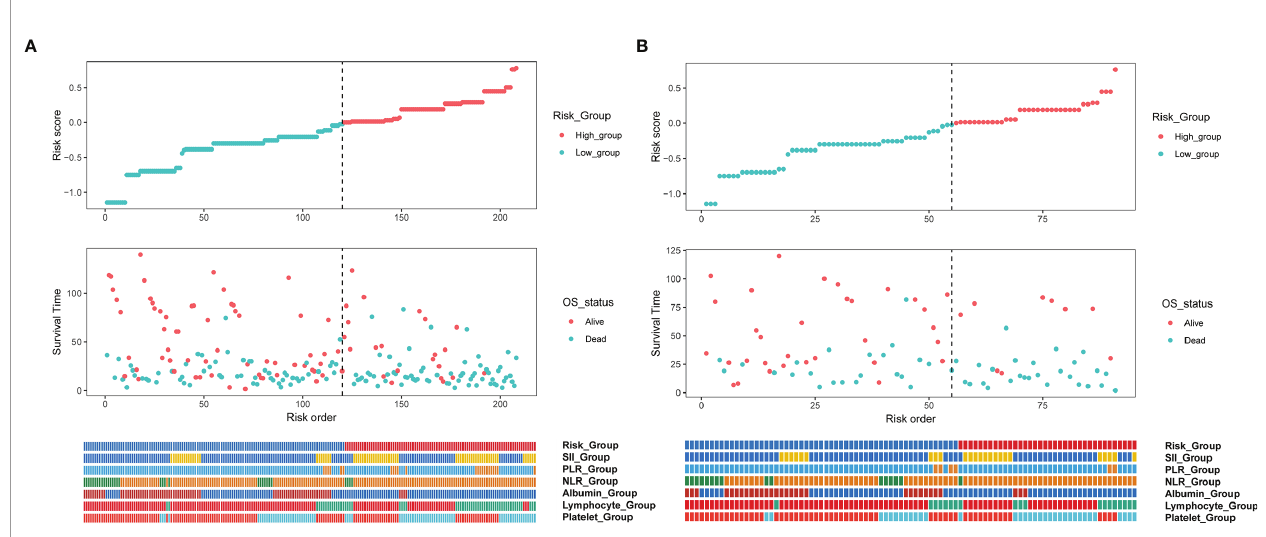
FIGURE 3 | Cox regression risk score distribution, prognostic relationship, and heatmap of the dichotomous data of the in fl ammatory components in Risk from (A) training and (B) validation cohorts. NLR, neutrophil-to-lymphocyte ratio; PLR, platelet-to-lymphocyte ratio; SII, Systemic In fl ammation